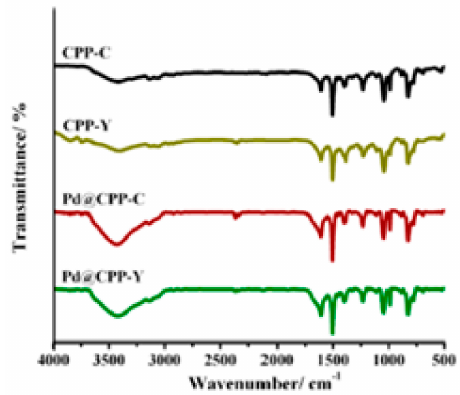
Figure 6. FT-IR spectra of neat POPs (CPPC and CPPY) and metal-encapsulated POPs (Pd@CPPC and Pd@CPPY). Reproduced with permission from [57]. Copyright 57, the American Chemical Society.